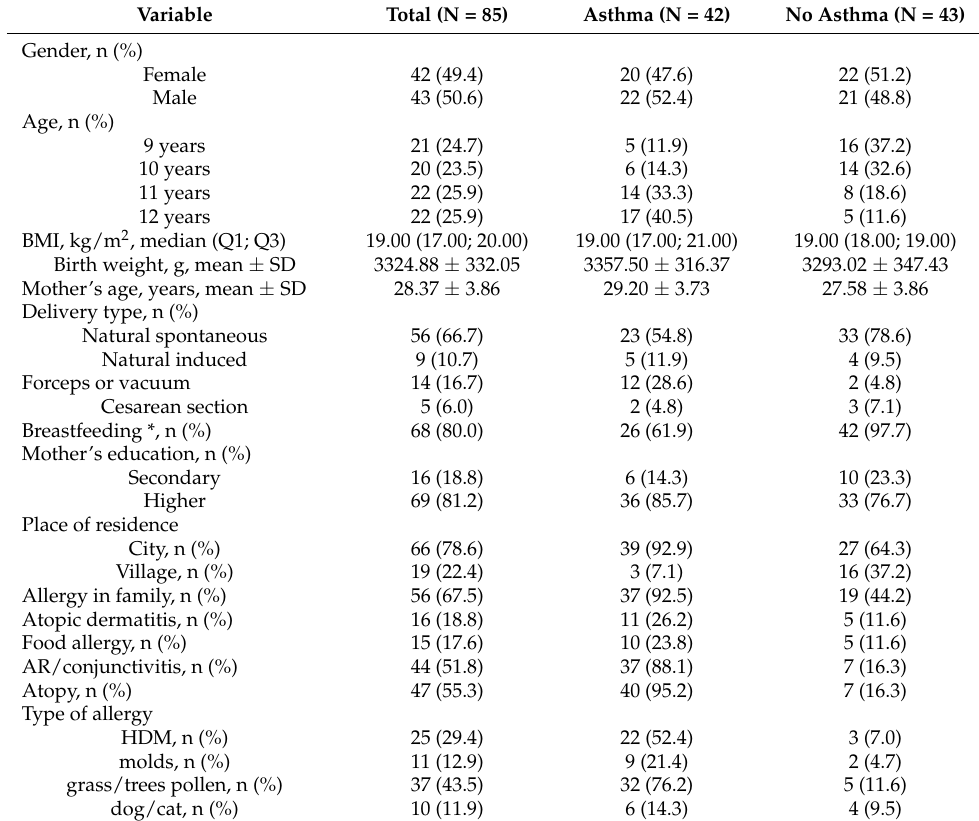
Table 1. Characteristics of the study group and control